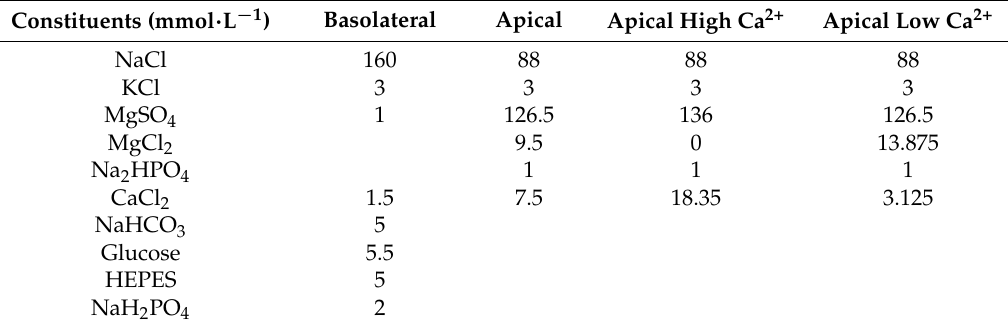
Table 2. Composition of basolateral and apical salines used in vivo tissue